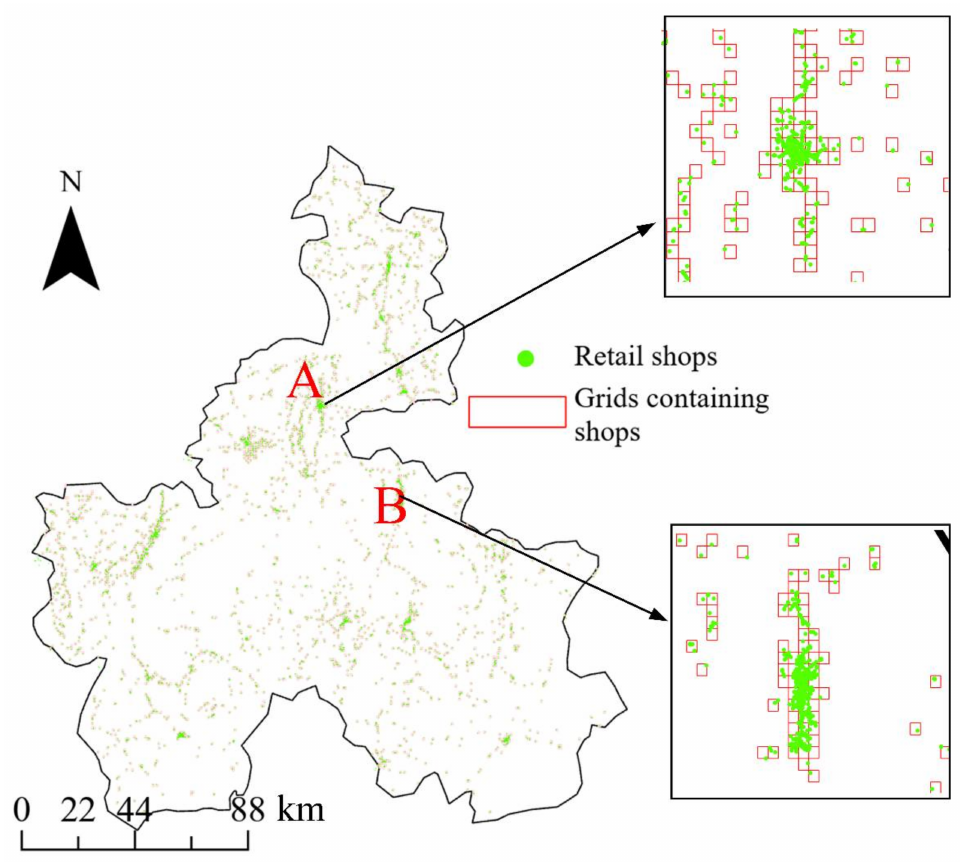
Figure 3. Distribution of retail shops and grids containing retail shops. A and B denote two sample regions Guiding County and Duyun County,